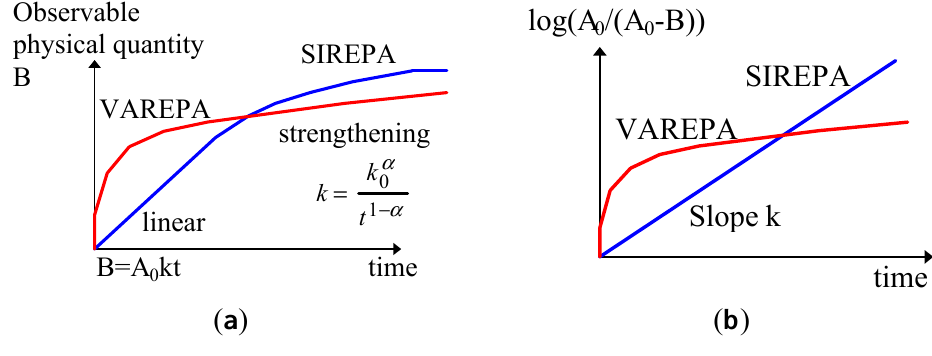
Figure 17. ( a ) B vs. time; ( b ) log(A 0 /(A 0 − B)) vs. time.